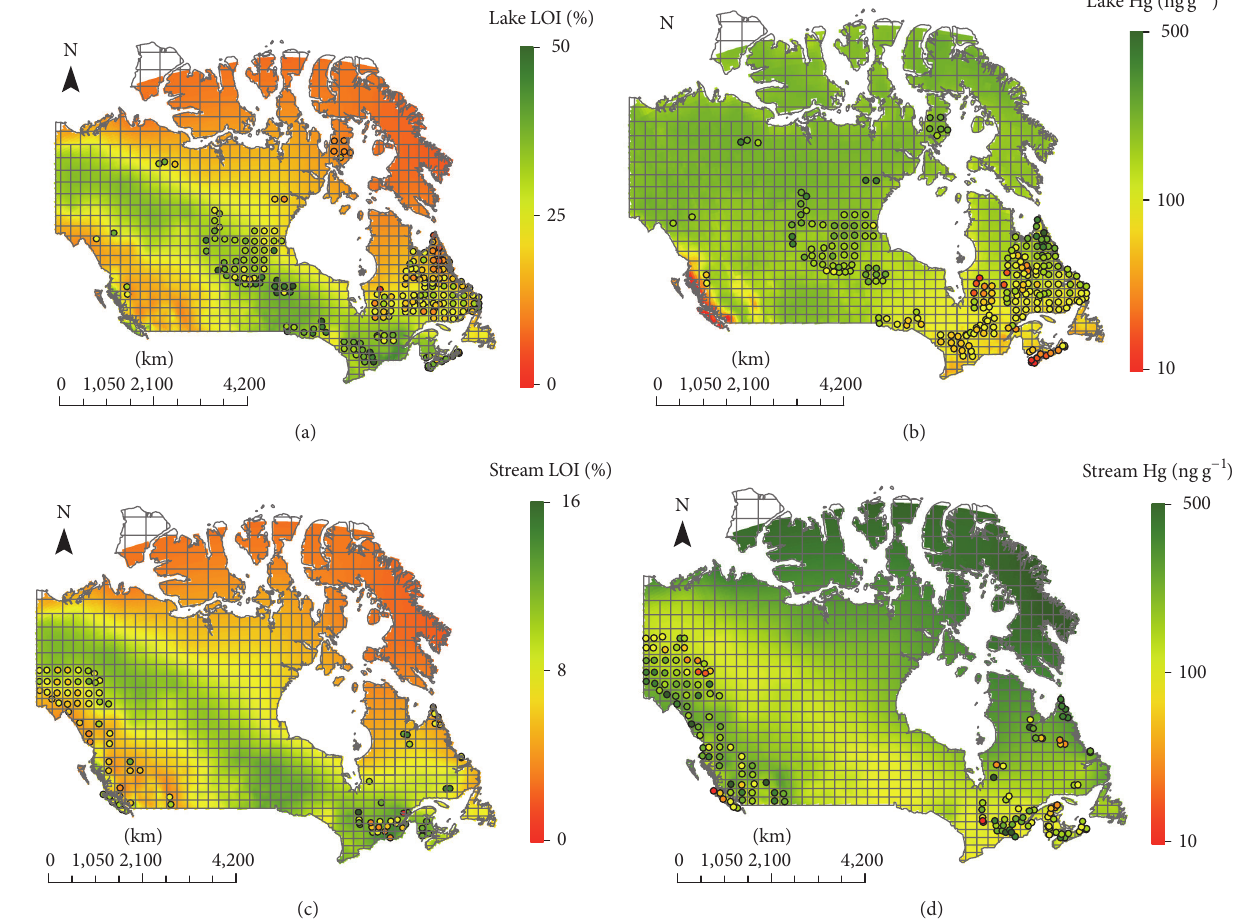
Figure 7: Sediment LOI (%) and THg (ngg −1 , log 10 scale) projected across Canada using (2)–(4). Overlaid dots: mean sediment THg value per NTS tile. (a and b) Lakes; (c and d)